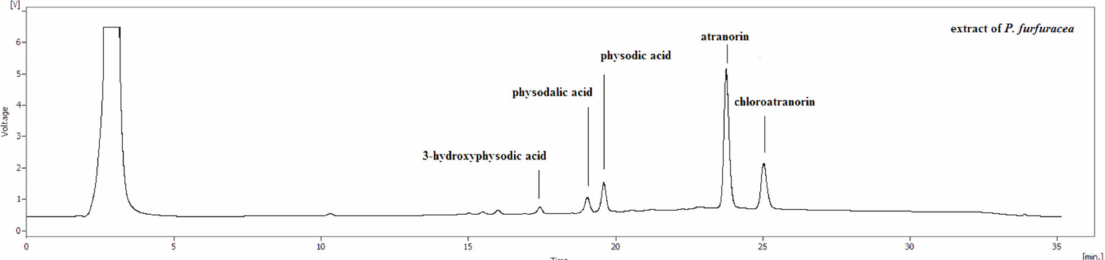
Figure 2. High-performance liquid chromatography (HPLC) chromatograph of identified lichen compounds from extract P. furfuracea (L.)